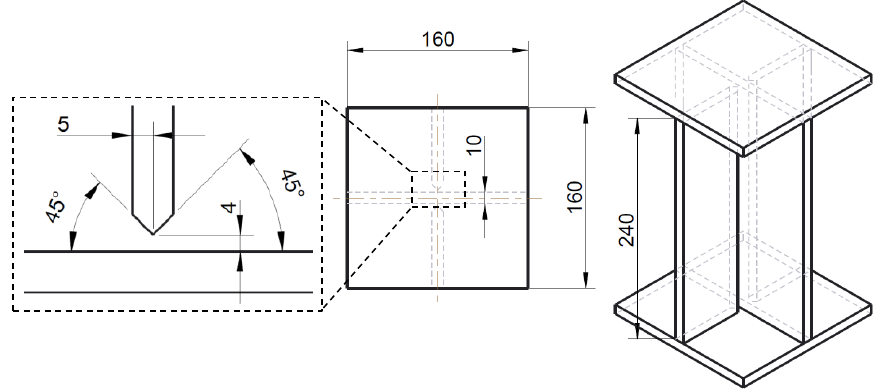
Figure 13. Dimension of an X-profile with a 10-mm plate thickness (without weld